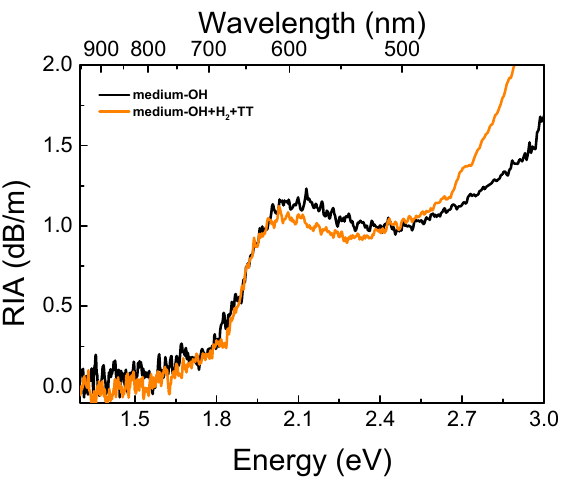
Figure 10. Measured RIA of the medium -OH and the treated medium -OH samples at a dose of 300 kGy.